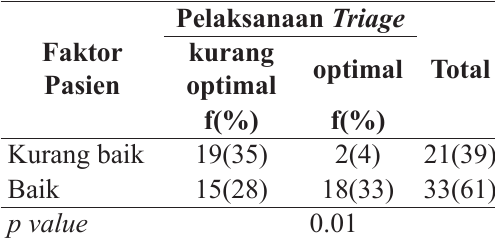
Tabel 3. Tabulasi silang faktor pasien